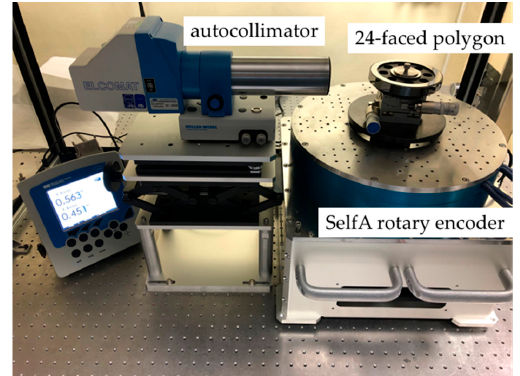
Figure 4. Photograph of the experimental setup.